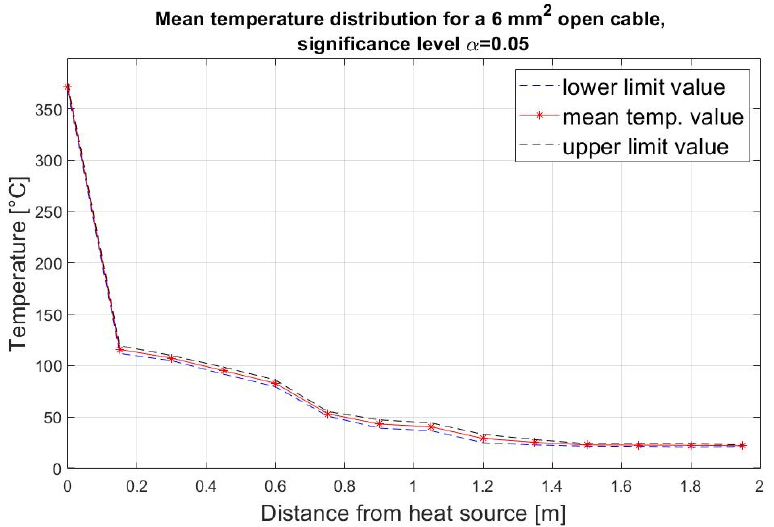
Figure 11. Cable temperature curve obtained through a measurement experiment depending on the distance from the heat source.